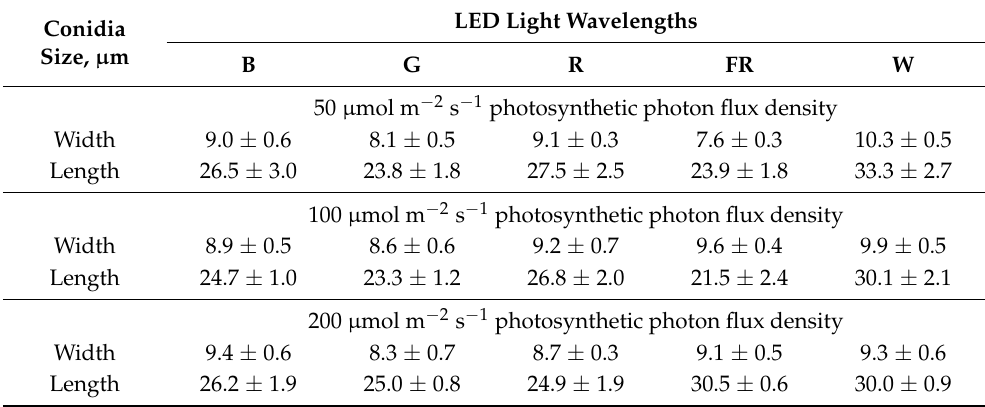
Table 3. Comparison of the average conidia size of C. acutatum after illumination by various LED light photosynthetic photon flux